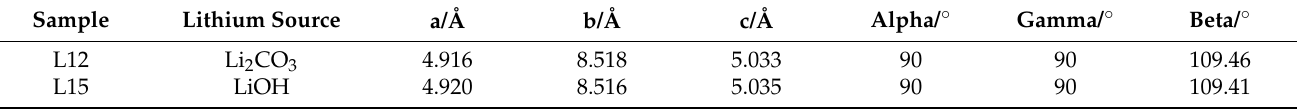
Table 5. Lattice parameters of samples L12 and L15 for existence of the monoclinic Li 2 MnO 3